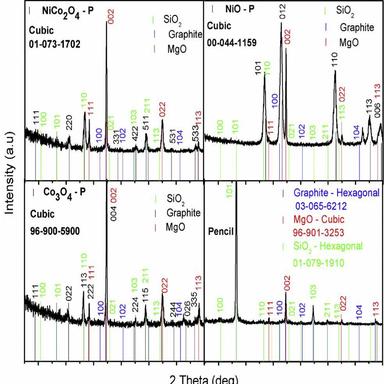
Powder XRD patterns of bare PGR, NiCo2O4eP, Co3O4eP, and NiOeP (P stands for PGR).